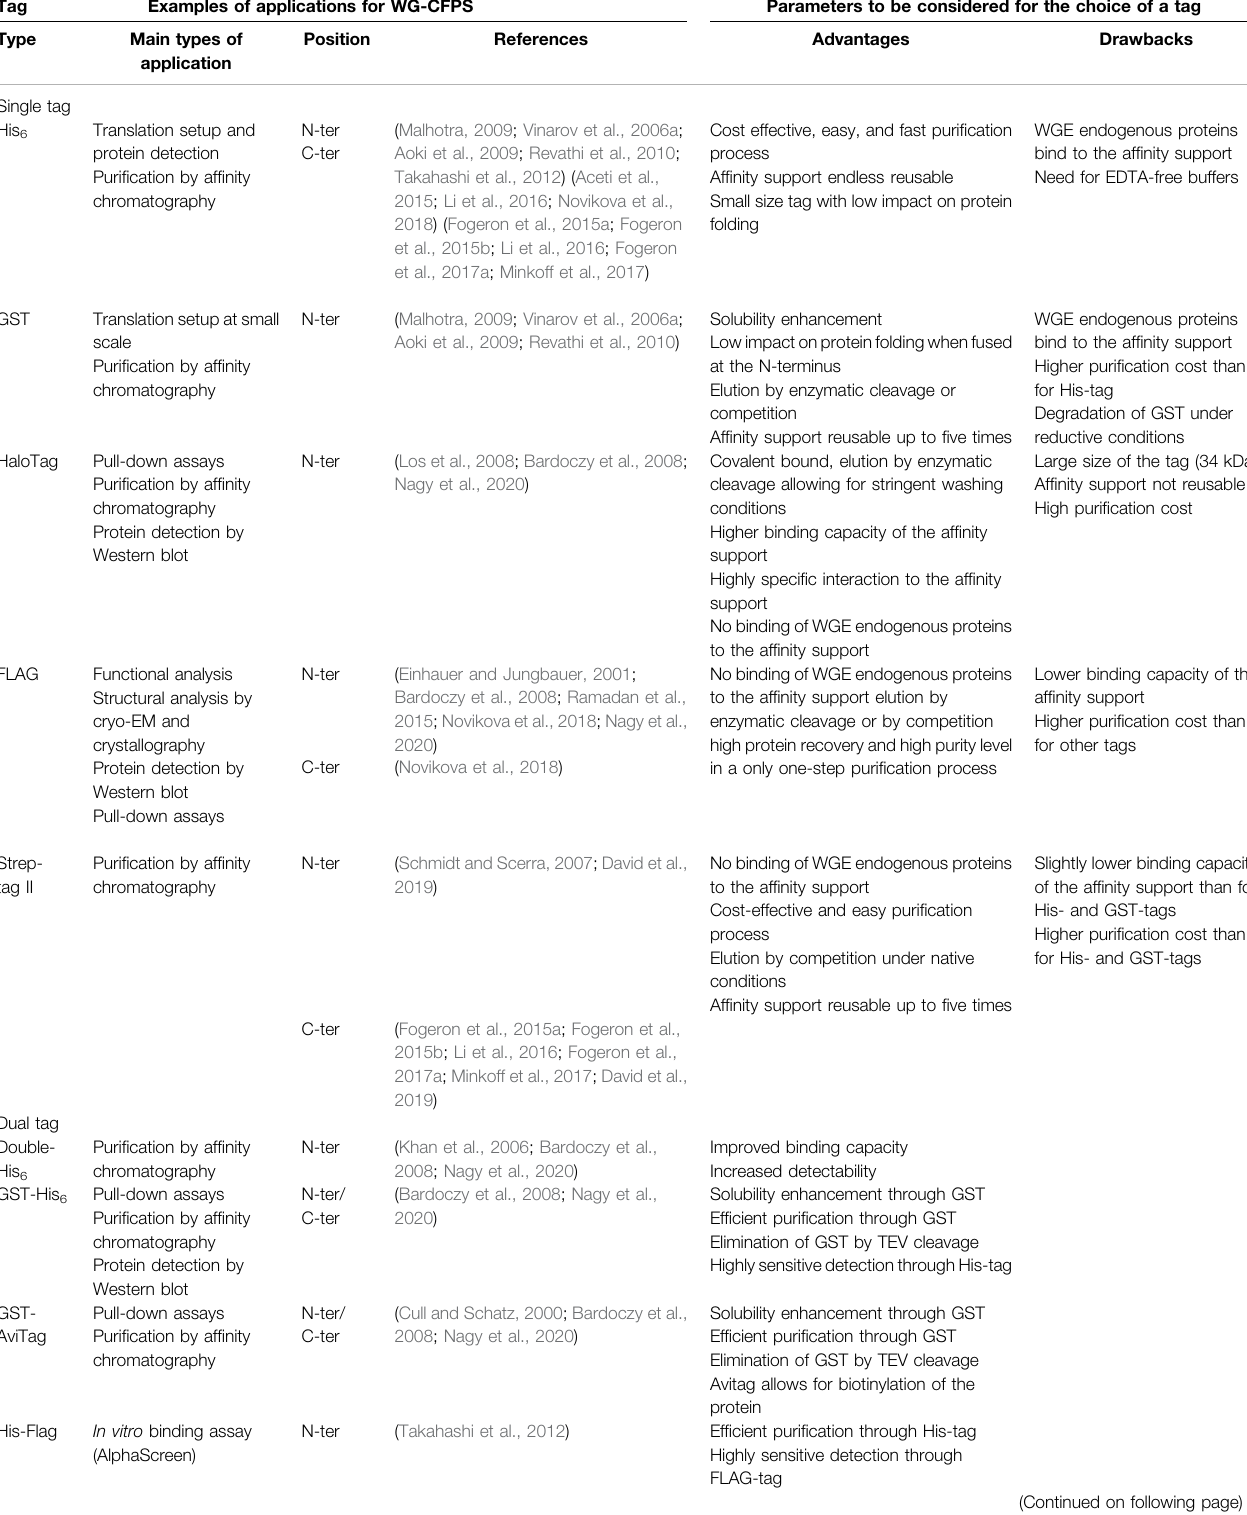
TABLE 2 | Summary of tags whose use has been described for protein expression with the